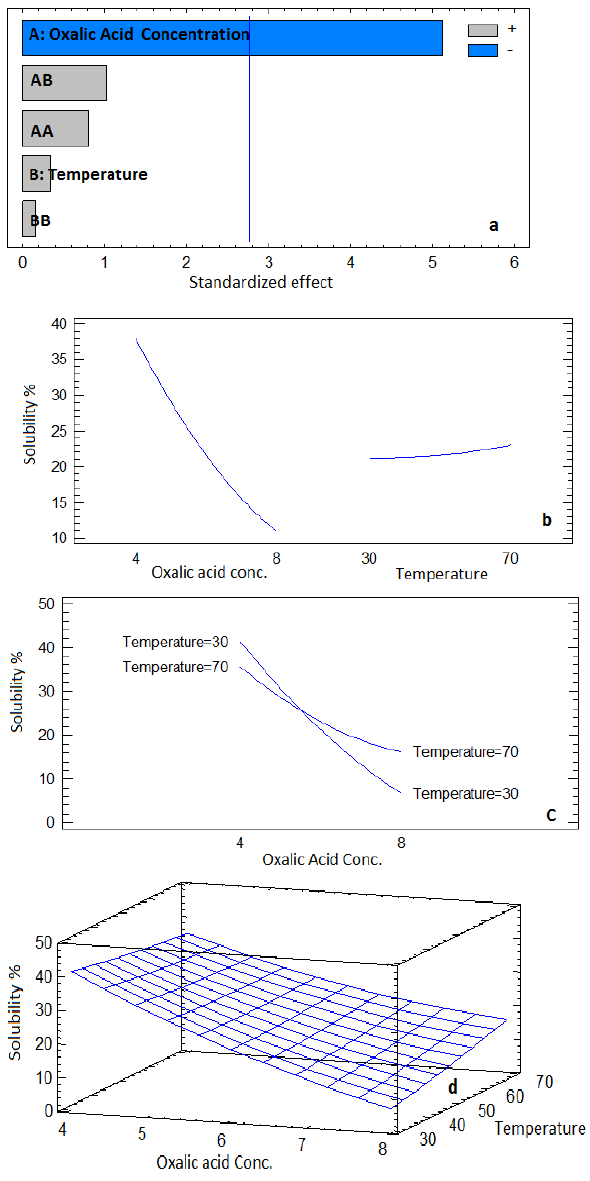
Figure 4. Pareto chart ( a ), standardized effects plot ( b ), interaction plots ( c ), for solubility (%), ( d ) 3D response surface.